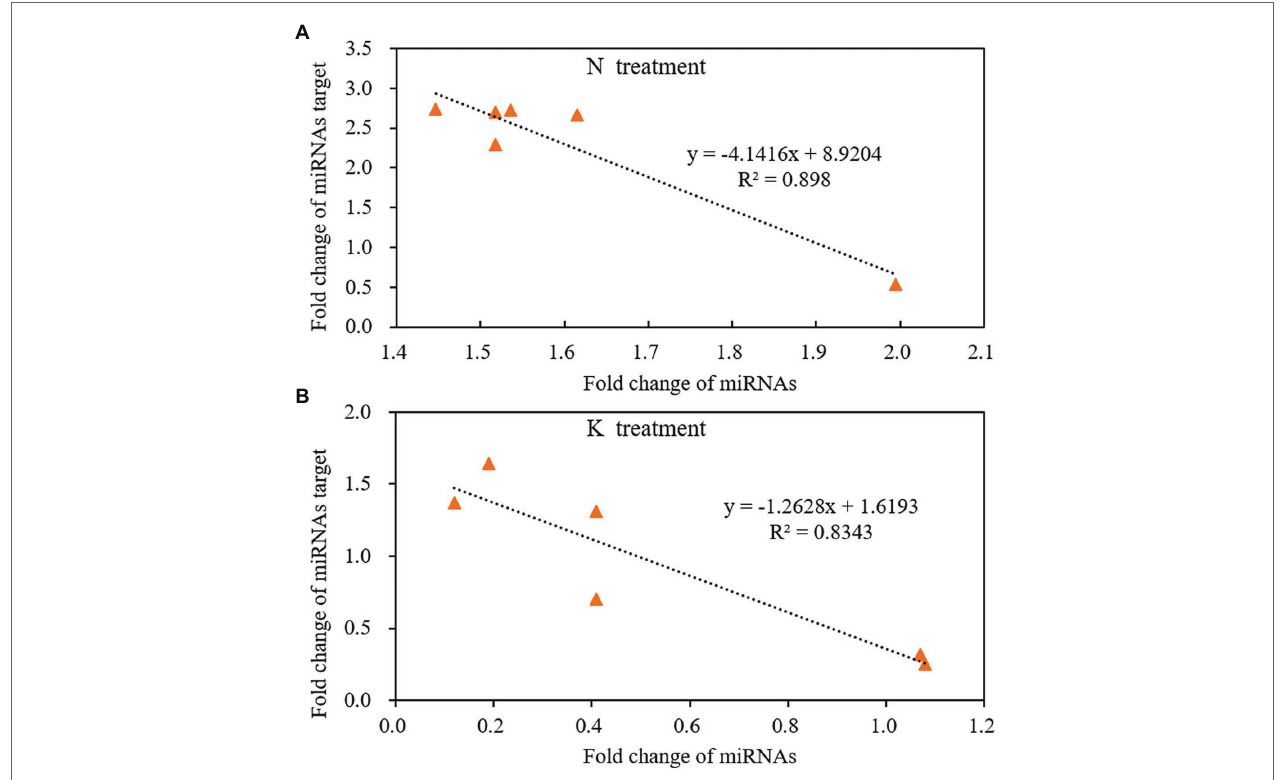
FIGURE 7 | The reverse liner relationship of fold change between miRNAs and their targets under N treatment (A) and K treatment (B) in the root of peanut seedlings. N, nitrogen and K,